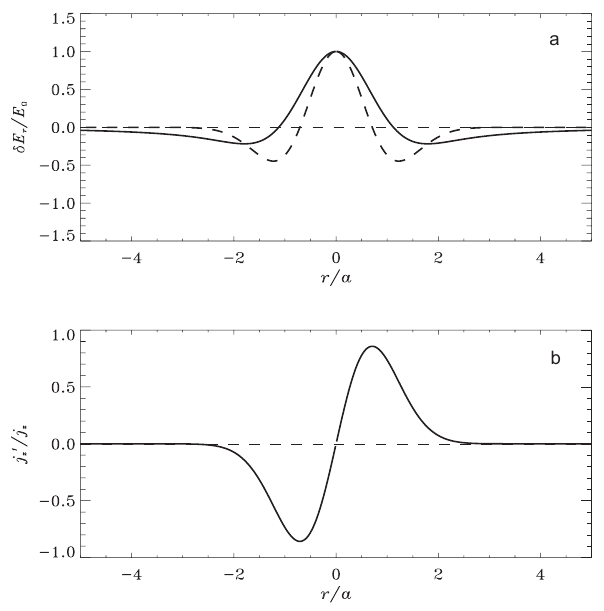
Fig. 5. (a) Normalised polarization electric field, δE r /E (cid:127) , in the case of weak skin effect (solid line) and (k 1 a) 2 δE r /E (cid:127) under the conditions of strong skin effect (dashed line) versus normalised ra- dial distance from the centre of heated spot; (b) radial profile of the 0 parallel current j z /j z